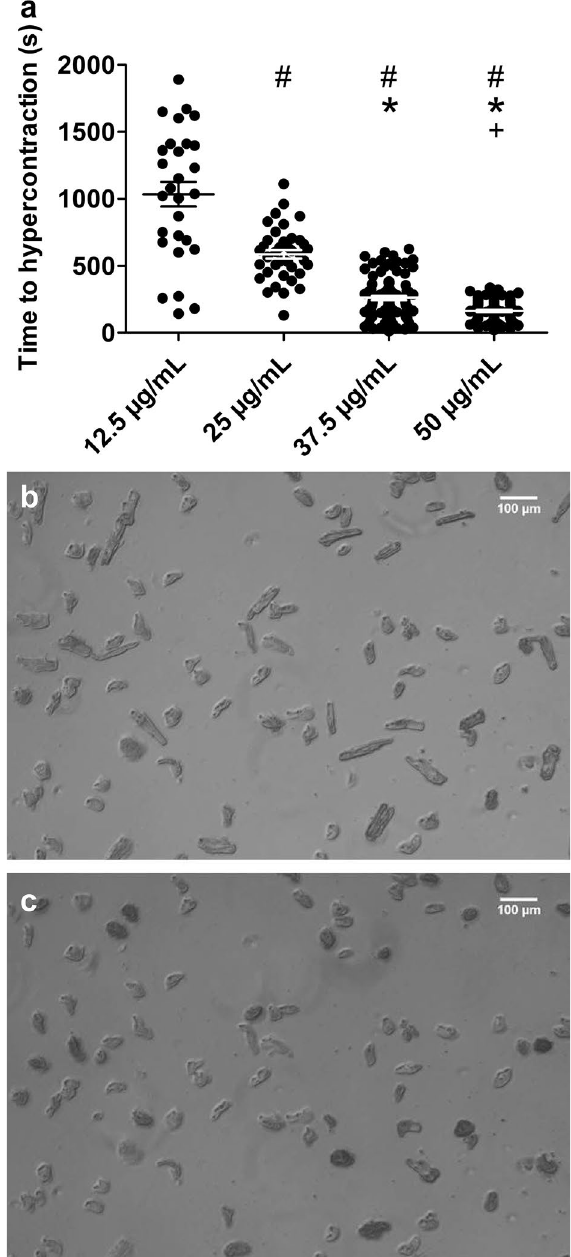
Figure 2. The general effect of Mt-II on intact cardiomyocytes is a permanent hypercontraction. ( a ) Intact cardiomyocytes were exposed to increasing Mt-II concentration in HEPES solution at 37 °C. A dose–response relation between Mt-II concentration and the time to reach hypercontraction was observed. Every dot represents a single cell. #, *, + : significantly shorter time to hypercontraction than at 12.5, 25 and 37.5 µg/mL, respectively (one-way ANOVA, F = 148.1, p < 0.001). Image created using GraphPad Prism (version 5.01) www. graph pad. com. ( b , c ) Bright-field microscopy images obtained during a typical experiment included in ( a ). The same region of a coverslip containing intact cells before ( b ) and after ( c ) exposure to 25 µg/mL Mt-II is shown. When exposed to Mt-II neighboring cardiomyocytes did not achieve hypercontraction simultaneously. After about 17 min of Mt-II exposure ( c ), however, all cardiomyocytes achieved hypercontraction. Supplementary videos 2 and 3 show original experiments of data included in a. Images acquired and processed using Olympus cellSens (version 2.3); https:// www. olymp us- lifes cience. com/ de/ softw are/ cells